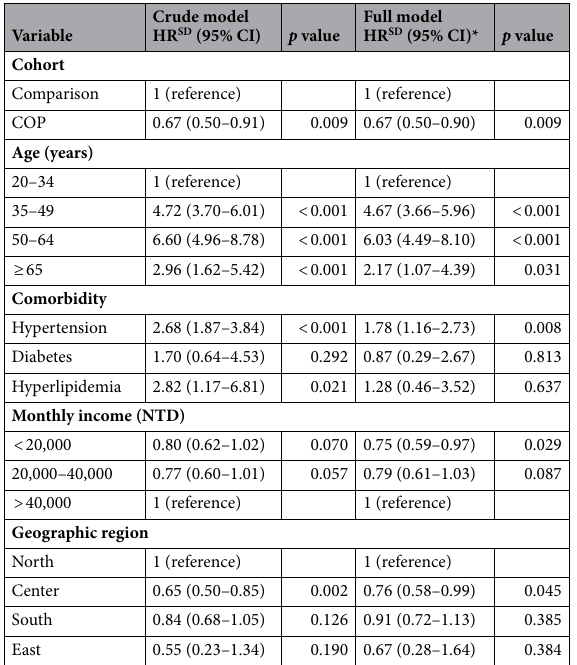
COP carbon monoxide poisoning, HR hazard ratio, AHR adjusted hazard ratio, HR SD adjusted competing risks hazard ratio, CI confidence interval, NTD New Taiwan Dollars. *Adjusted for age, hypertension, diabetes, hyperlipidemia, monthly income, and geographic region.